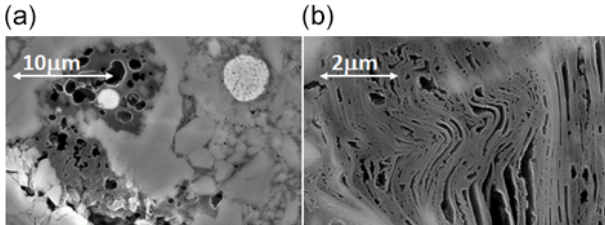
Figure 2. SEM images of shale samples at different resolution. (a) A “sponge-like” kerogen porosity and a framboidal pyrite, (b) a lamellar clay structure filled by porous kerogen.